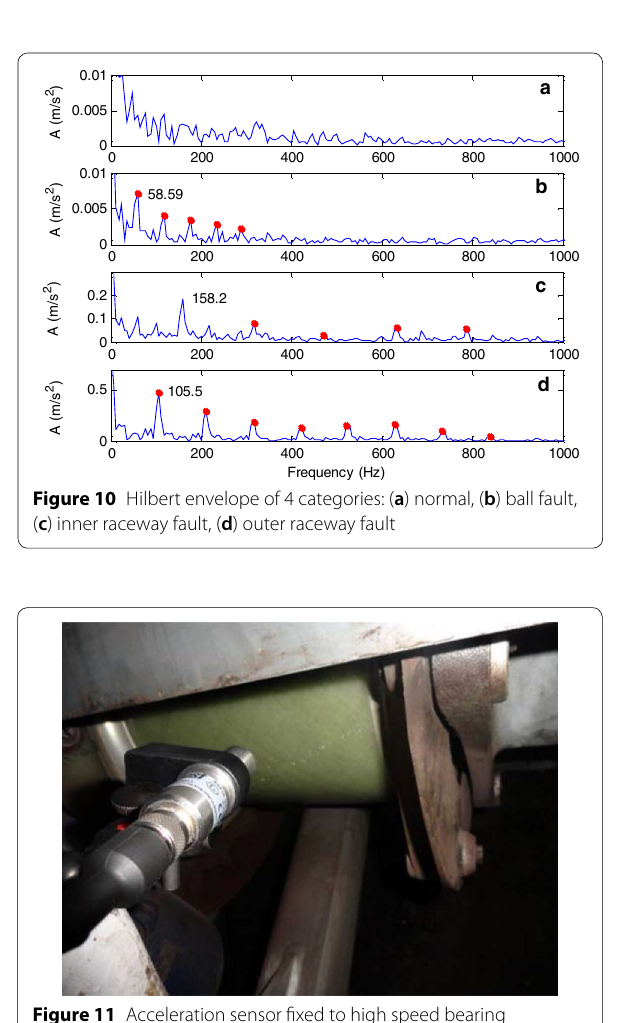
Figure 11 Acceleration sensor fixed to high speed bearing